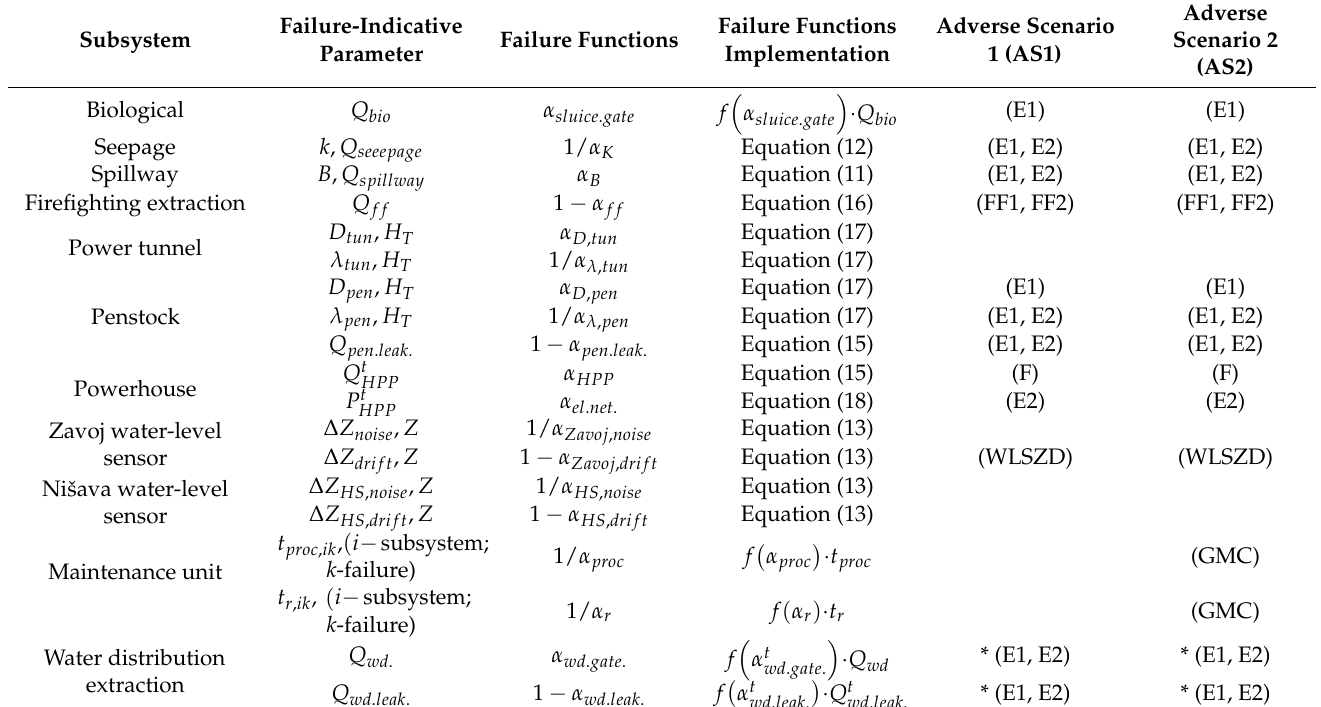
Table 3. List of the subsystems with identified failure-indicative parameters and examples of func- tionality indicator implementation in the Pirot DRS SD